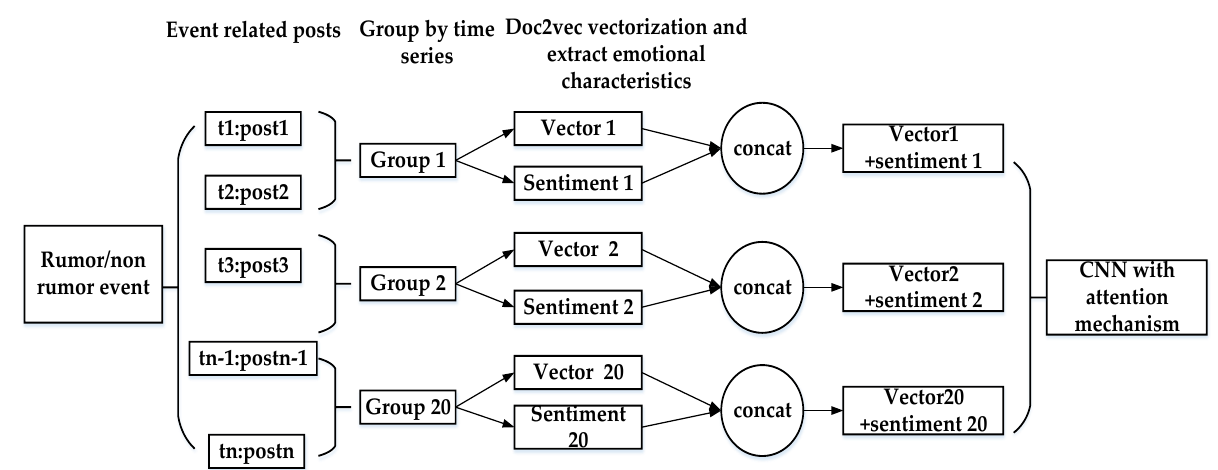
Figure 1. The overall framework of CNN-TS + Sentiment + Attention.